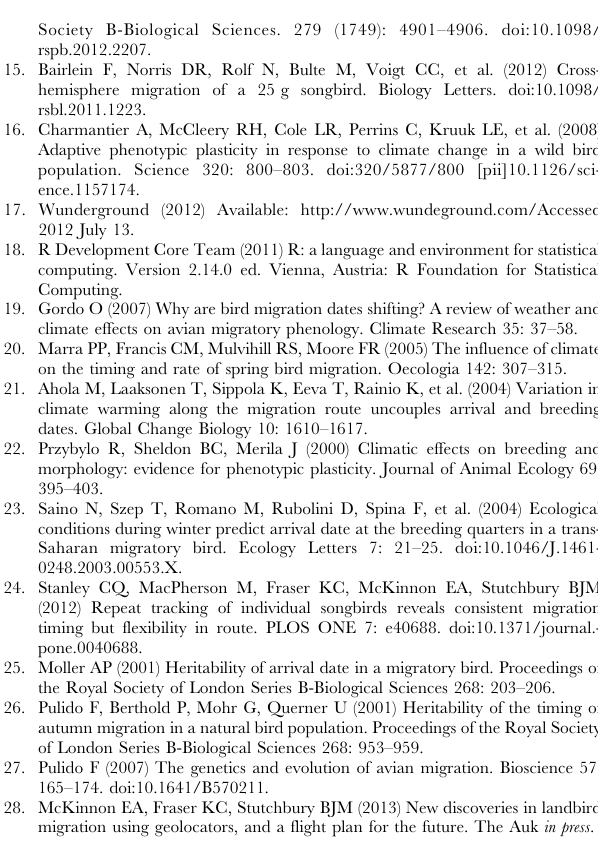
Table S1 Geolocator deployment locations, year, type, number of units deployed, geolocators retrieved (does not include birds who lost tags) and total sample size for spring migration (excludes tags that failed prior to spring migration). Most (75%) geolocators were 1.1 g with a , 10 mm stalk (MK10S, British Antarctic Survey) and were mounted using a leg-loop backpack harness